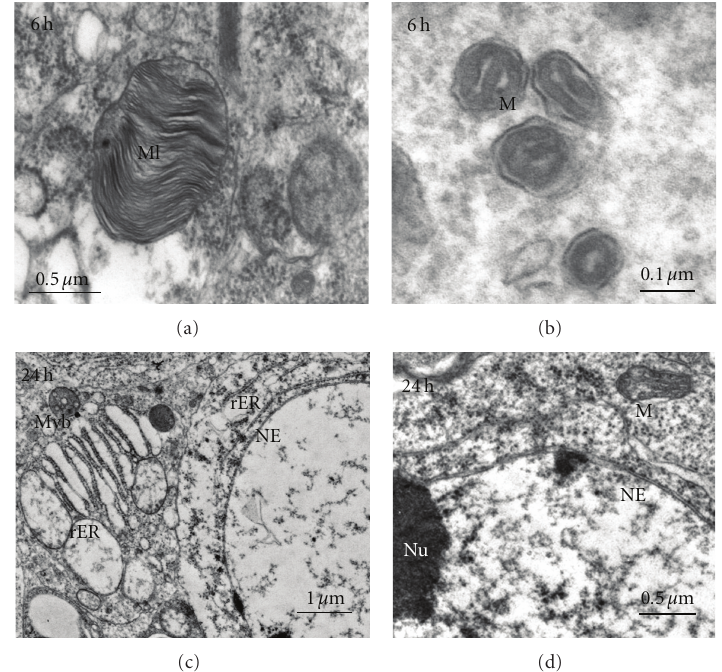
Figure 2: Venom-induced changes in neuronal ultrastructure in brain tissue from young pharate adults of S. bullata envenomated by N. vitripennis . Following venom injection, some host brain cells (a) displayed prominent multilamellar bodies (Ml) by 6hr postenvenomation. The mitochondria (M) in the 6hr (b) and 24 hr (d) cells displayed similar structure with no evidence of swelling of the intermembrane space. By 24 h postenvenomation, some cells (c) contained multivesicular bodies (Mvb) and very swollen rough endoplasmic reticulum (rER), while others (adjacent cells in (c)) appeared to contain healthy rER. NE: nuclear envelope.